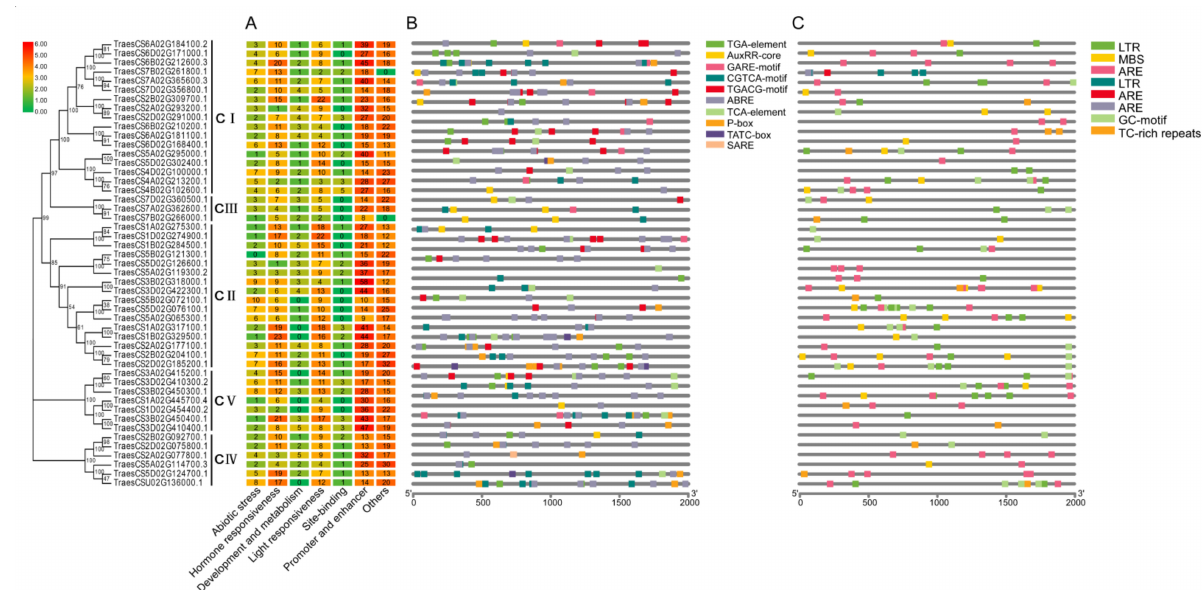
Figure 4. Predicted cis-acting elements in TaHDAC genes. ( A ) All cis-acting elements are divided into 7 classifications; the number of cis-acting elements in the promoter region of each TaHDAC gene is counted. ( B ) The cis-acting elements related to auxin (IAA), gibberellin (GA), methyl jasmonate (MeJA), abscisic acid (ABA), and salicylic acid (SA) identified in the promoter region of each TaHDAC gene. ( C ) The abiotic stress-related cis-acting elements identified in the promoter region of each TaHDAC gene.